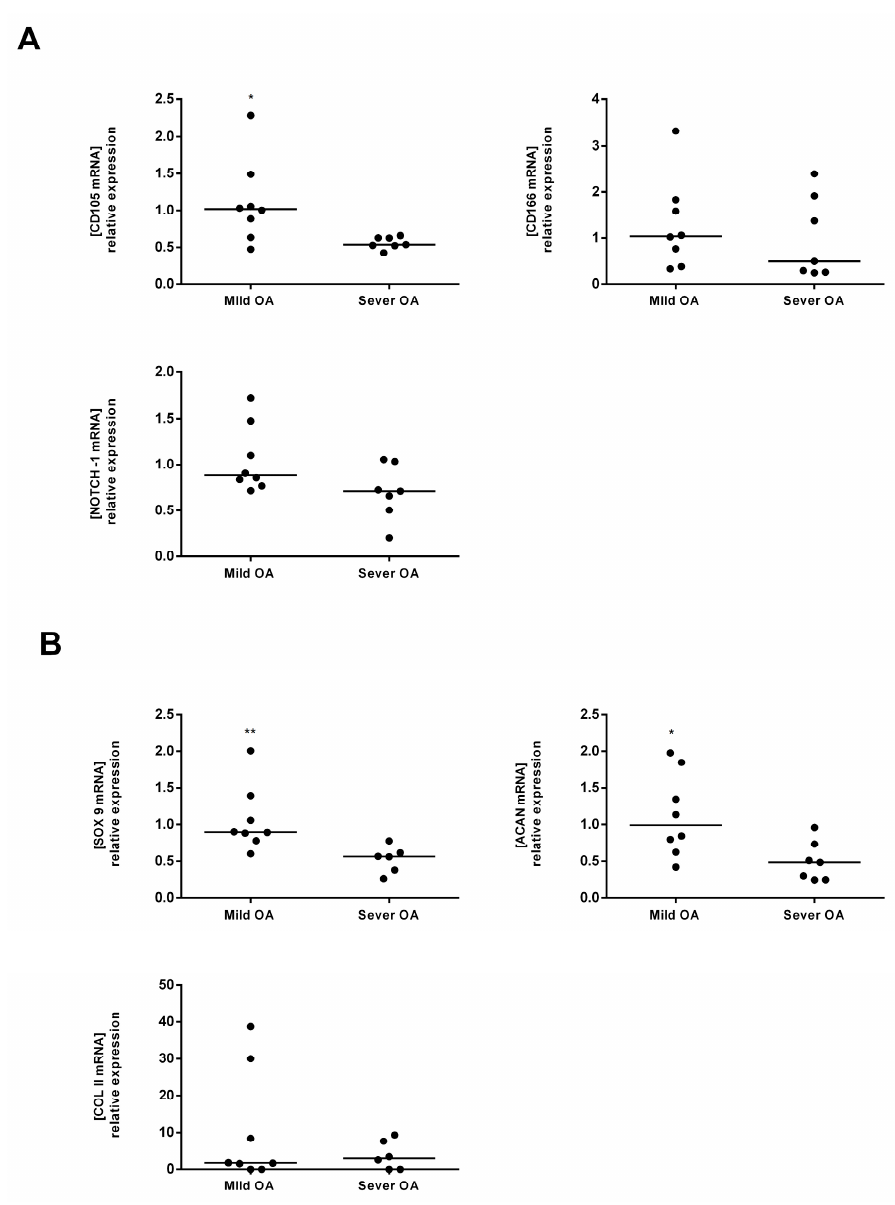
Figure 6. Comparative analysis of MSC and Chondrocyte markers in proliferated cells (D14) isolated from mild and severe OA regions. ( A ) The mRNA expression levels of CD105, CD166 and Notch 1 (MSC markers) in mild versus severe OA at D14; ( B ) The mRNA expression levels of Sox9, Acan and Col II (chondrocytes markers) in mild versus severe OA at D148. Mild OA is used as the control expression to normalized results. * p < 0.05, ** p < 0.01, Student’s t -test ( n = 8 in Mild OA, n = 6 in severe OA).